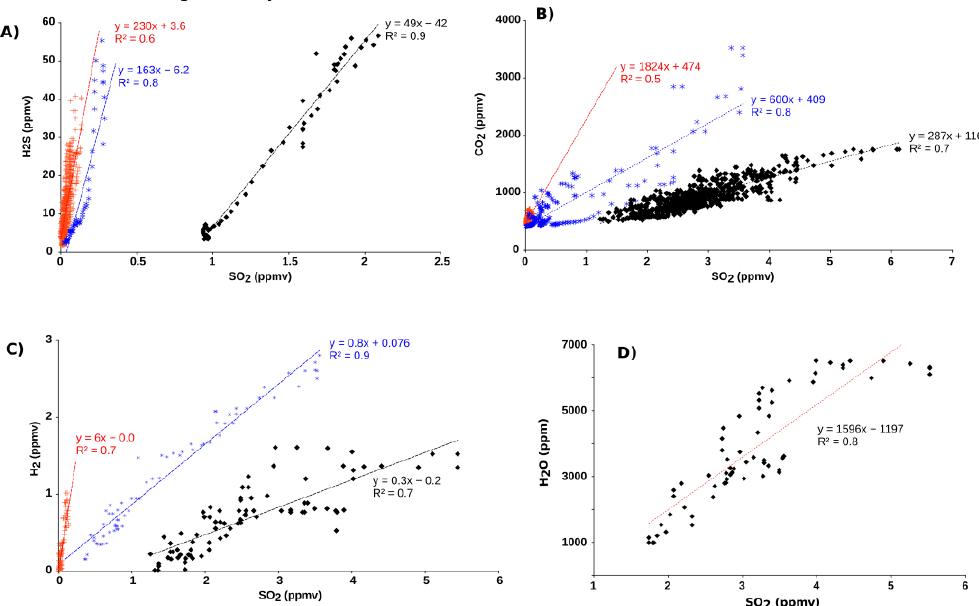
Figure 4. Linear correlation between H2S and SO 2 ( A ), CO 2 and SO 2 ( B ), H 2 and SO 2 ( C ) and H 2 O and SO 2 ( D ) from MG_Pt1 (red), MG_Pt2 (blue) and MG_Pt3 (black). For H 2 S, the saturated points were excluded whilst the correlation between H 2 O and SO 2 was obtained only at MG_pt3 ( D ).